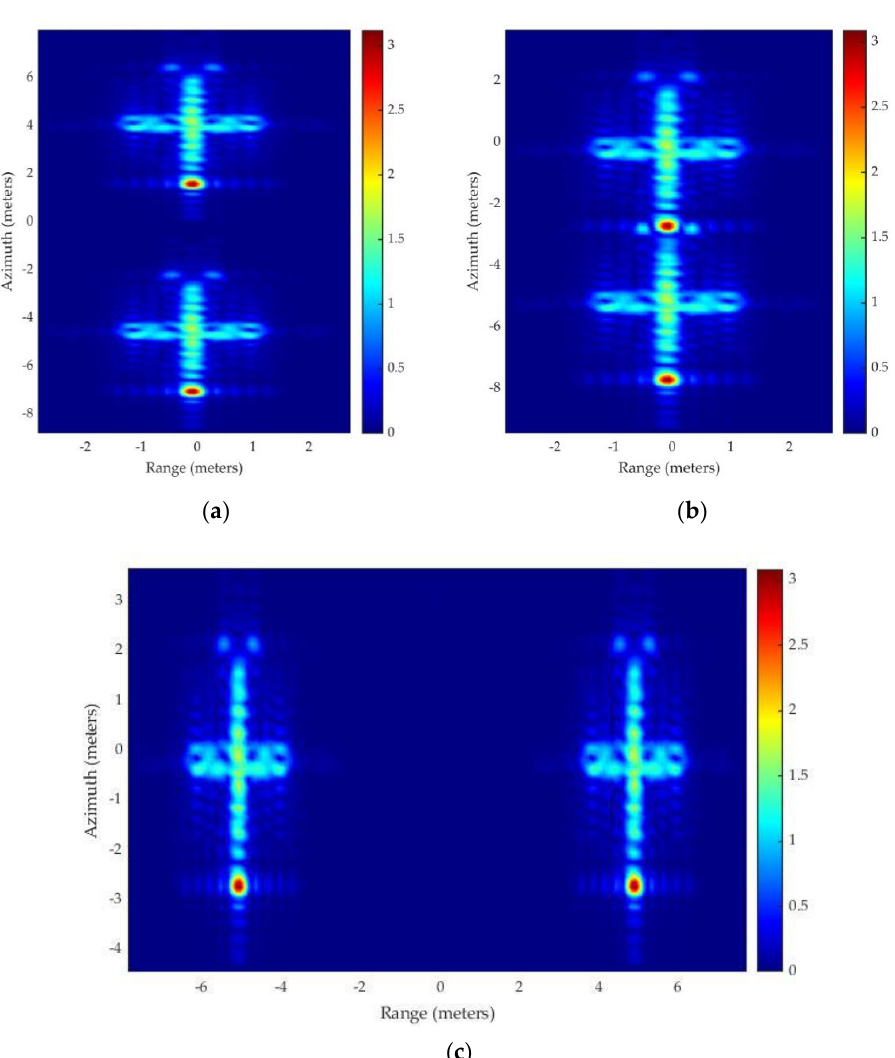
Figure 10. SAR images of missile−like targets in the free space: ( a ) two targets located at the same height and in a tandem array in the free space; ( b ) two targets located at a different height and parallel to each other in the free space; ( c ) two targets located at the same height and parallel to each other in the free